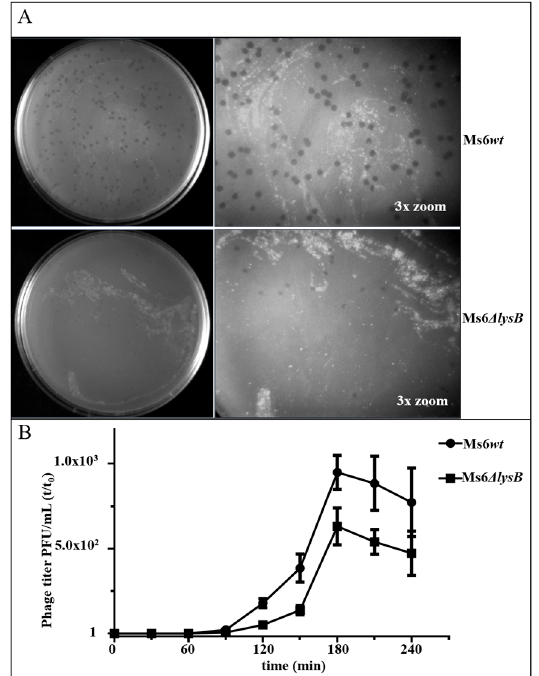
Figure 2. ( A ) Phage plaques formed by Ms6 (top) or Ms6 Δ lysB (bottom) on a lawn of M. smegmatis . The plaques formed by Ms6 Δ lysB phage are smaller than the ones formed by the wild-type Ms6; ( B ) one-step growth curves of Ms6 wt (circles) or Ms6 Δ lysB (squares) on M. smegmatis mc 2 155 show a lower number of plaque-forming units (PFU) released from Ms6 Δ lysB infection. Both curves show similar progression up to 90 min post-adsorption showing no differences in the timing of lysis. T0 marks the end of the adsorption and start of the one-step experiment. The PFU/mL at t = 0 was used to normalize PFU/mL of each time point. For each time point, the mean ± SD of four independent assays is indicated.